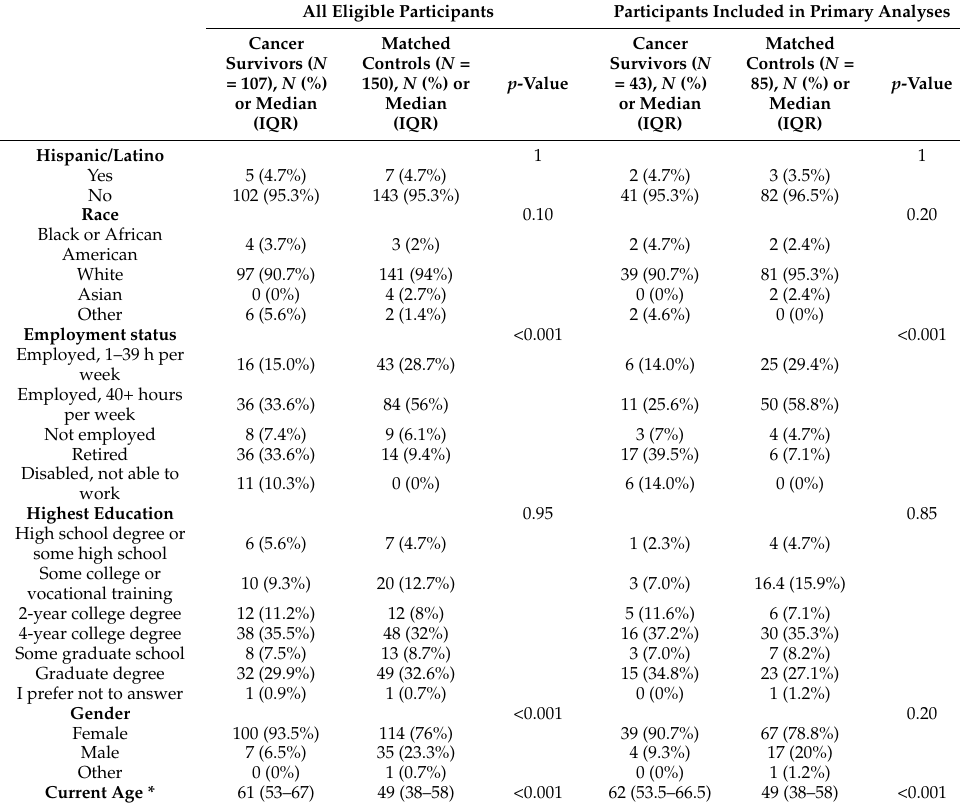
Table 1. Demographic characteristics of eligible